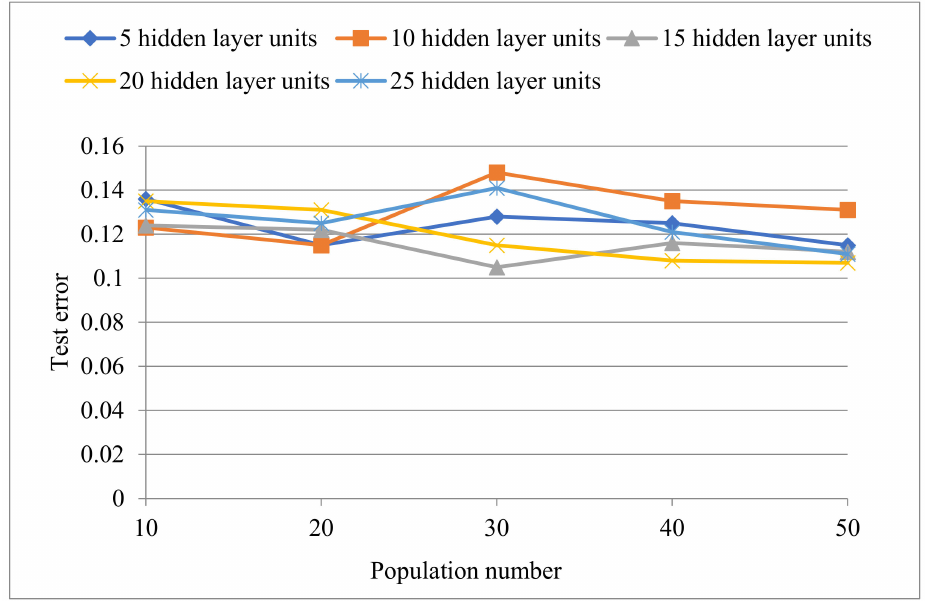
Figure 2. Test error of different